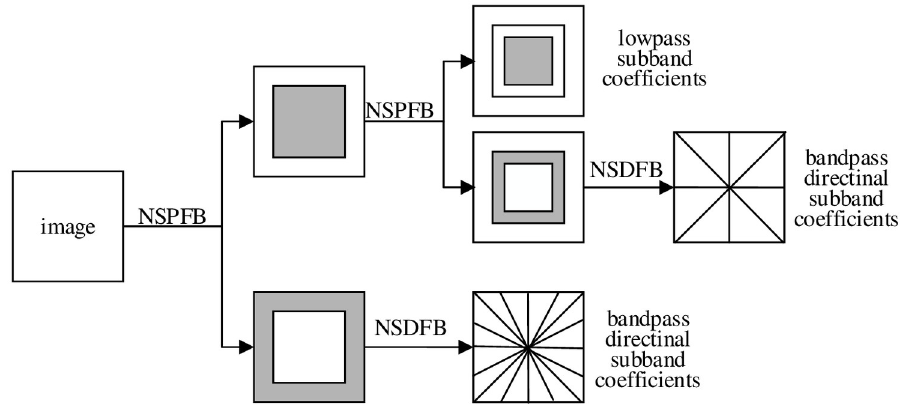
Fig 1. Two-level decomposition of NSCT.